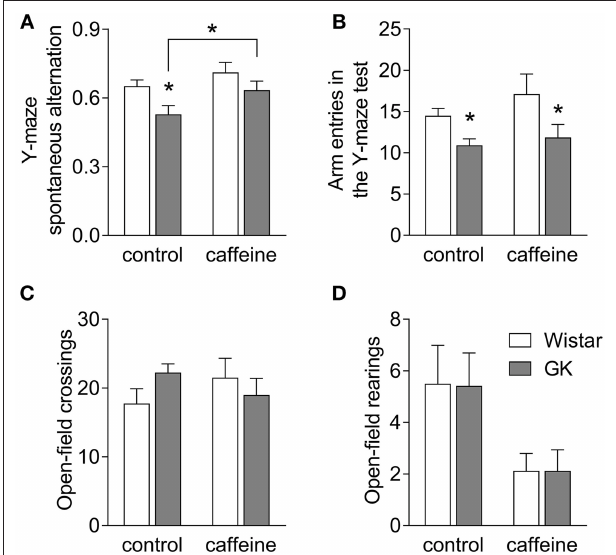
FIGURE 2 | Caffeine consumption improves spatial working memory deficits in diabetic GK rats. GK rats displayed reduced spontaneous alternation in the Y-maze, when compared to controls, but not if treated with caffeine for 4 months (A) . The number of entries in the Y-maze arms was lower in GK compared to control rats irrespective of caffeine consumption (B) . The number of crossings in the open-field arena was unaltered by diabetes or caffeine consumption (C) , but the number of rearing events was reduced upon chronic caffeine consumption (D) . Data are mean ± SEM of 8 rats per group. Symbols represent LSD test results after ANOVA with either significant diabetes effect or significant diabetes-caffeine interaction: * P < 0.05 for GK vs. Wistar in the respective treatment group or as